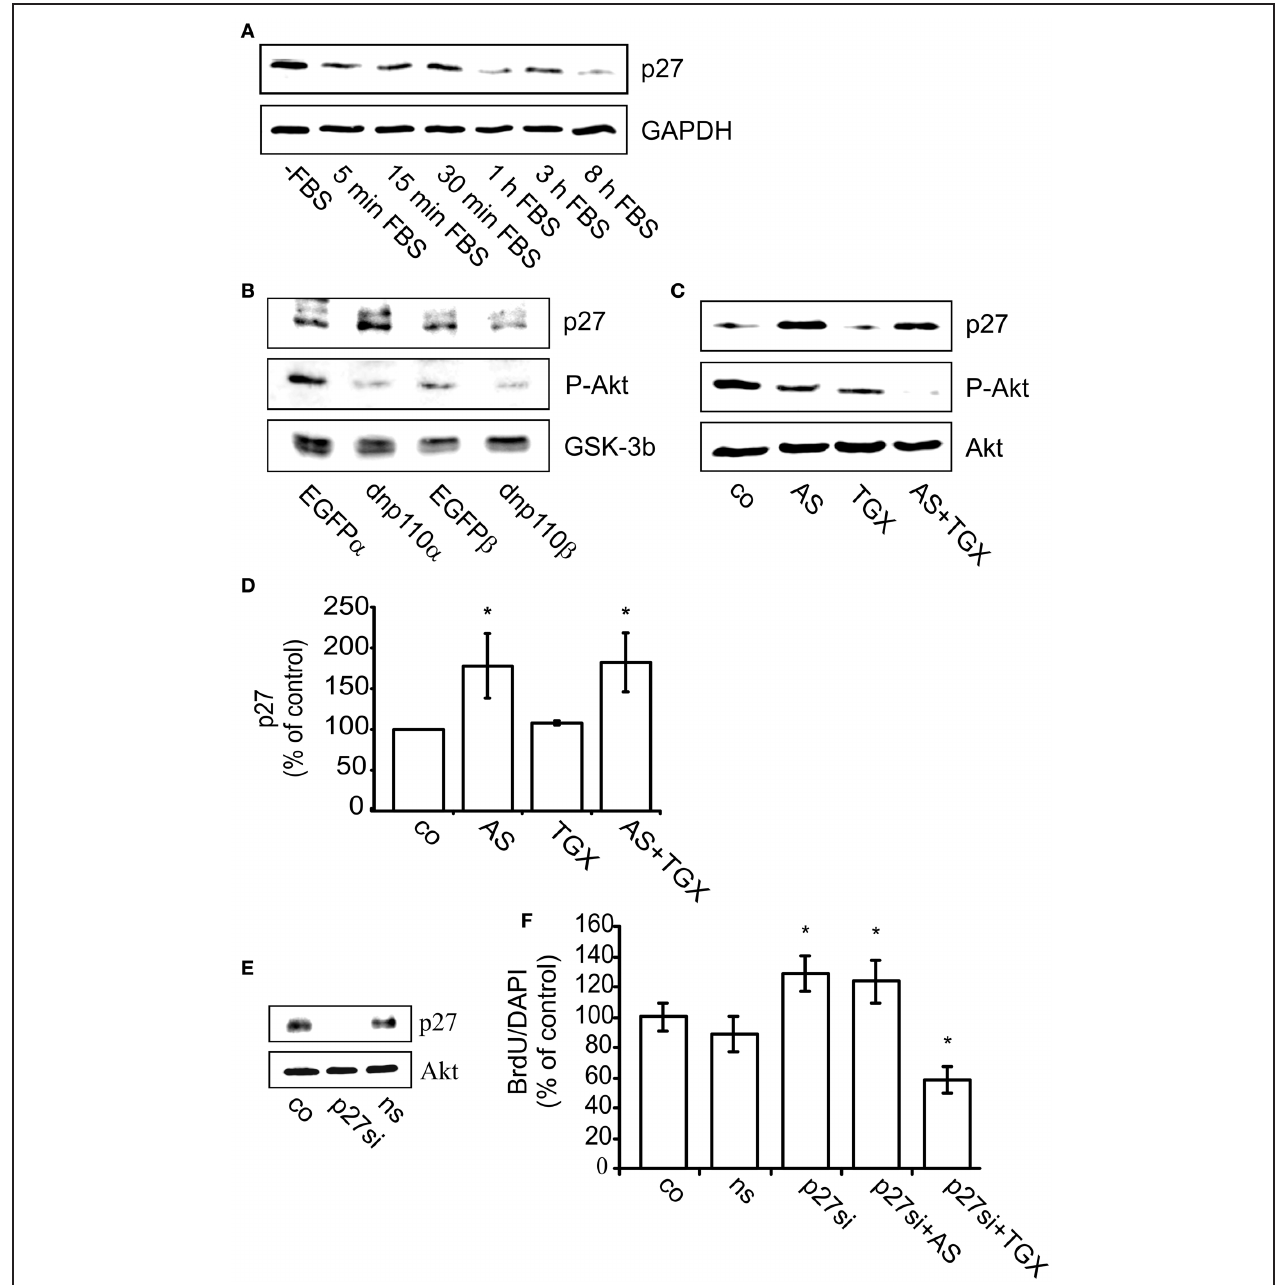
FIGURE 4 | Inhibition of p110 α enhances the cellular level of p27 Kip1 and thereby reduces BrdU uptake. (A) Upper lane: p27 Kip1 levels in cells maintained in FBS-free culture medium (-FBS) for 24h or after re-addition of 10% FBS for 5min up to 8h. Lower lane: GAPDH served as input control. (B) Upper lane: levels of p27 Kip1 in cells expressing dnp110 α K802R (dnp110 α ) or p110 β K805R (dnp110 β ). After prior FBS withdrawal for 24h, 10% FBS had been added for 8h. Controls for dnp110 α ∼ EGFP α ; controls for dnp110 β ∼ EGFP β ;P-Akt levels are shown the middle lane. GSK-3 β served as input control (lower lane). (C) Upper lane: levels of p27 Kip1 in cells treated with AS-252424 (5 μ M, AS) and/ or TGX-221 (200nM, TGX). After prior FBS withdrawal, 10% FBS which contained the drugs had been added for 8h; P-Akt levels (middle lane); total Akt served as input control (lower lane). (D) Quantification of the Western blot experiments. The ratio of the density